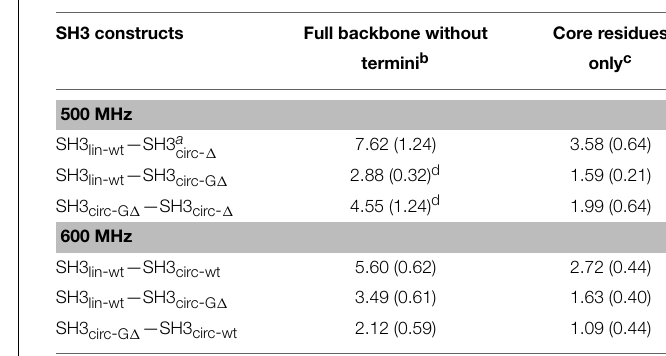
TABLE 4 | Differences in the backbone entropy between the SH3 constructs studied